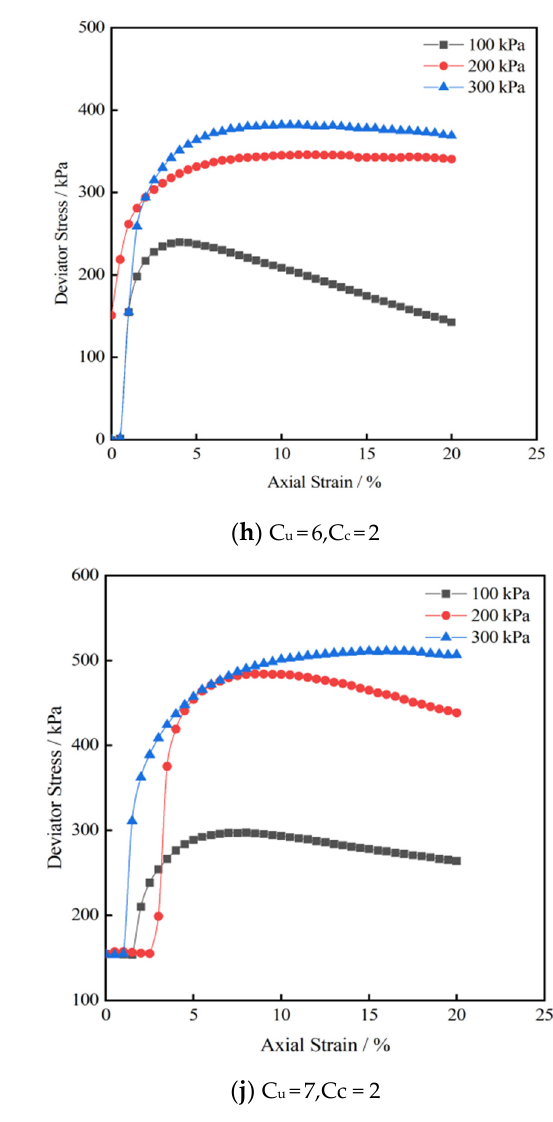
Figure 17. Stress–strain curve. Table 5. Strength record table under different test conditions.